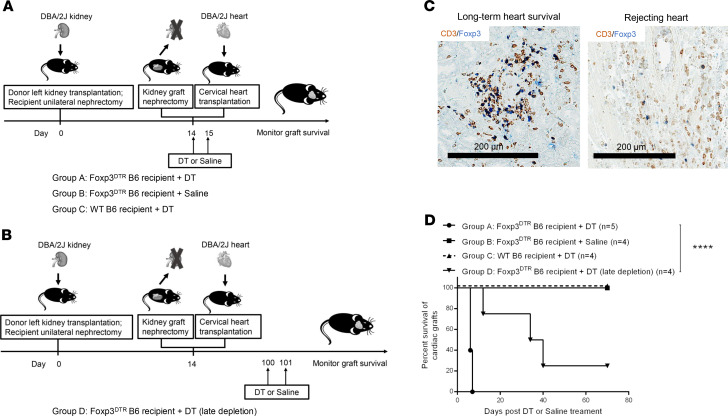
Depletion of Foxp3+ cells on cardiac graft survival.(A) Schematic representation of the experimental design to assess the effect of early depletion of Foxp3+ Tregs on cardiac graft survival in KICAT. DBA/2 kidneys were first transplanted into unilaterally nephrectomized WT or Foxp3DTR B6 recipients; 14 days later, kidney grafts were removed and recipients received cervical DBA/2 heart transplants, combined with either DT or saline treatment, cardiac grafts survival was then monitored. Animals were divided into the following groups: group A (Foxp3DTR B6 recipient + DT); group B (Foxp3DTR B6 recipient + saline); group C (WT B6 recipient + DT). (B) Schematic representation of experimental design to assess the effect of late depletion of Foxp3+ Tregs on cardiac graft survival in KICAT. DBA/2 kidneys were first transplanted into unilaterally nephrectomized Foxp3DTR B6 recipients; 14 days later, kidney grafts were removed and recipients received cervical DBA/2 heart transplants. One hundred days after transplantation of cardiac allografts, recipient animals received DT treatment (group D), and survival of cardiac allografts was monitored. (C) Double immunohistochemical staining of CD3 (brown) and Foxp3 (blue) of DBA/2 heart allografts from long-term tolerant recipients (>day 70), including cotransplant recipients (left), and rejected cardiac grafts (≤day 7) (right). Scale bars: 200 μm. (D) Survival curves of cardiac grafts in each experimental group described in B and C (group A, n = 5; group B, n = 4; group C, n = 4; group D, n = 4). Graft survival curves were constructed by the Kaplan-Meier method. ****P < 0.0001, log-rank test.